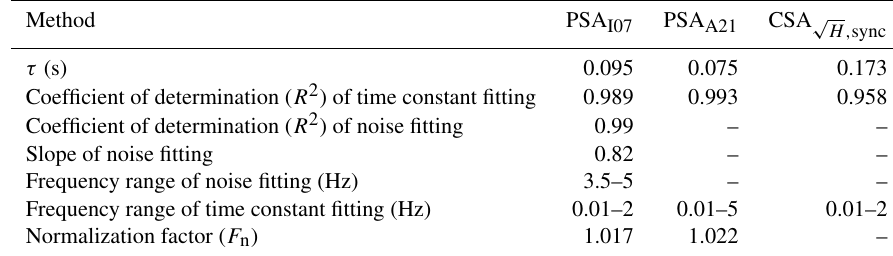
) for CO 2 data from the Siikaneva site and H, sync H, sync